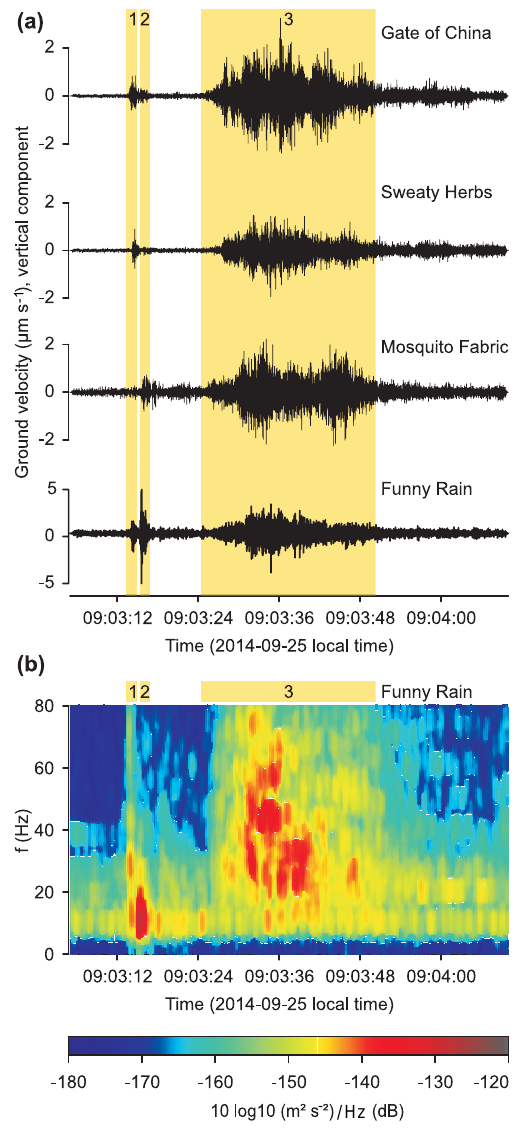
Figure 2. Anatomy of a 0.891 ± 0.038m 3 large rockfall event (event 7 from Table 2). (a) Seismic waveforms of four stations fil- tered between 1 and 90Hz of four stations (see Fig. 1 for locations). (b) Power spectral density estimate of station “Funny Rain”. Two distinct, short seismic activity phases (yellow polygons 1 and 2) are followed by an emergent and prolonged period of activity (yellow polygon 3) after 7.5s of